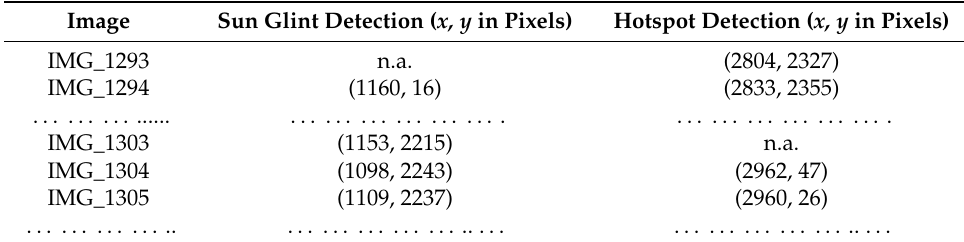
Table 3. Example of hotspot and sun glint detection in image coordinates.